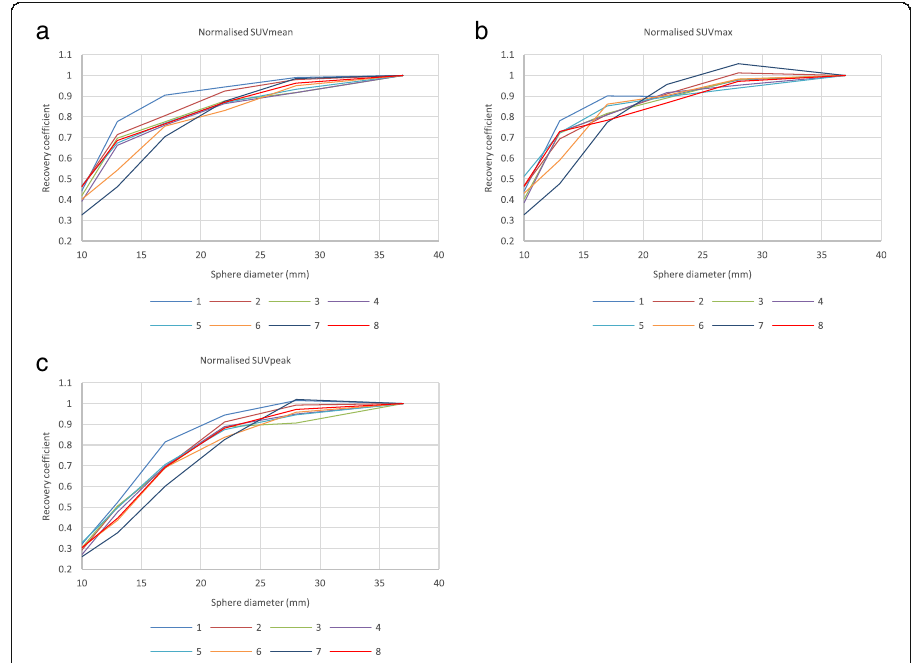
Fig. 5 RC curves normalised to the largest sphere, derived from the phantom experiments using SUVmean ( a ), SUVmax ( b ) and SUVpeak ( c ) quantitative metrics. Systems 1 – 2 and 3 – 4 represent GE scanners Discovery 690 and Discovery 710, respectively; systems 5 – 6 are Siemens Biograph 40_mCT and Somatom Definition AS_mCT; system 7 is the Philips Ingenuity TF PET/CT; system 8 is the Siemens Biograph